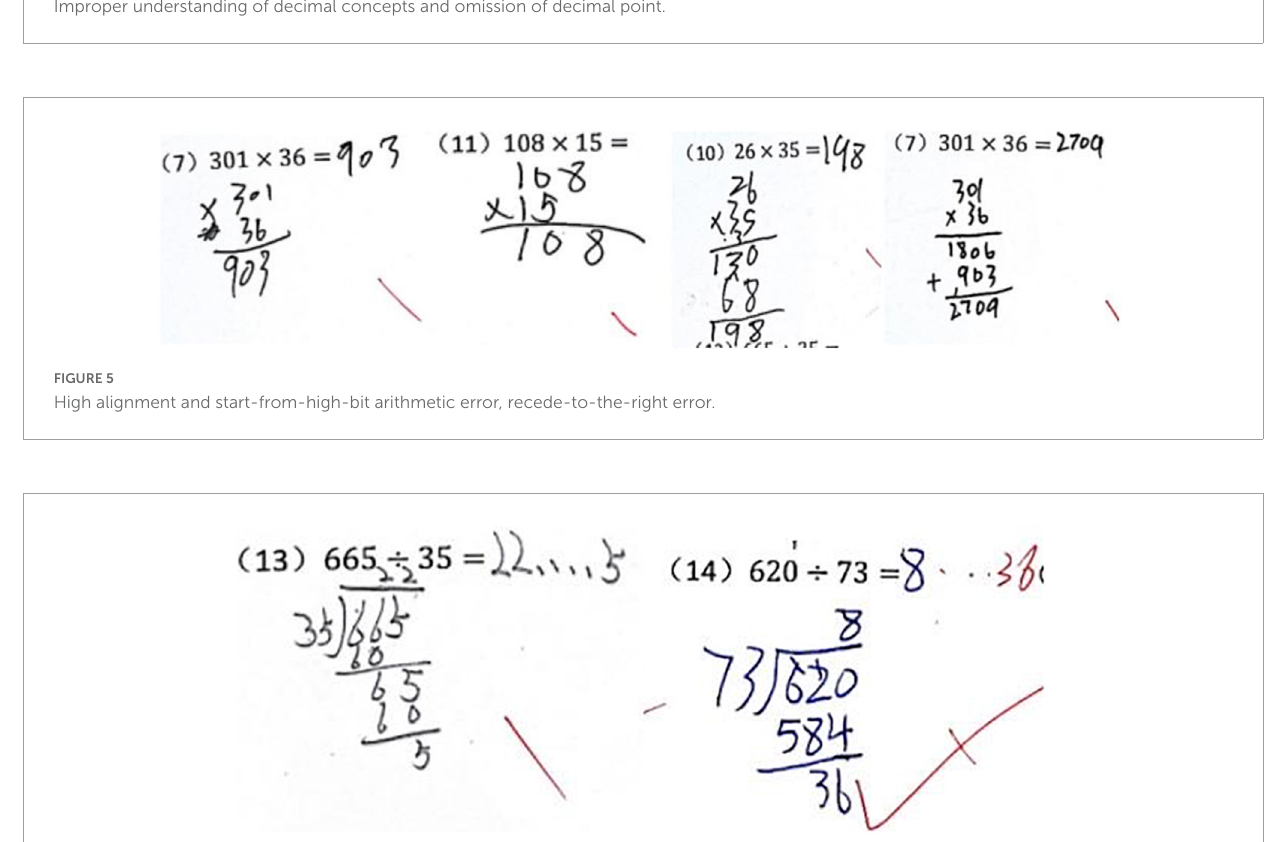
FIGURE4 Improper understanding of decimal concepts and omission of decimal point.